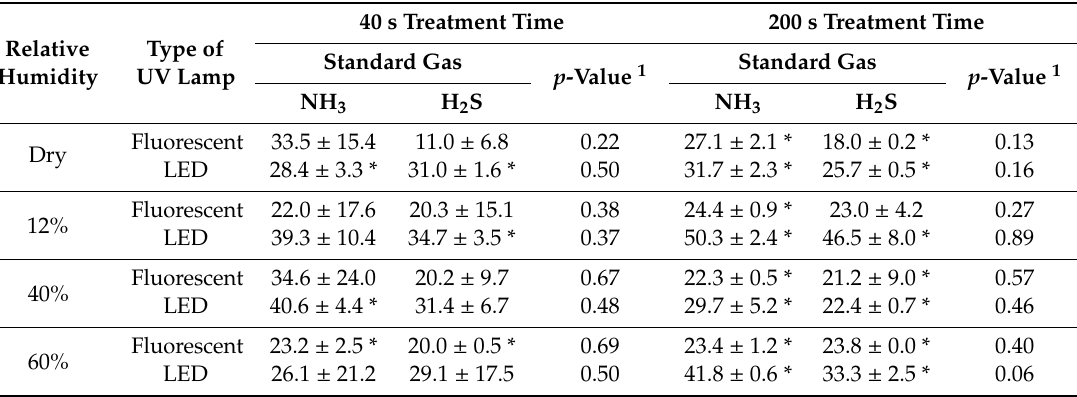
Table 4. The mitigation of O 3 at photocatalysis under NH 3 and H 2 S standard